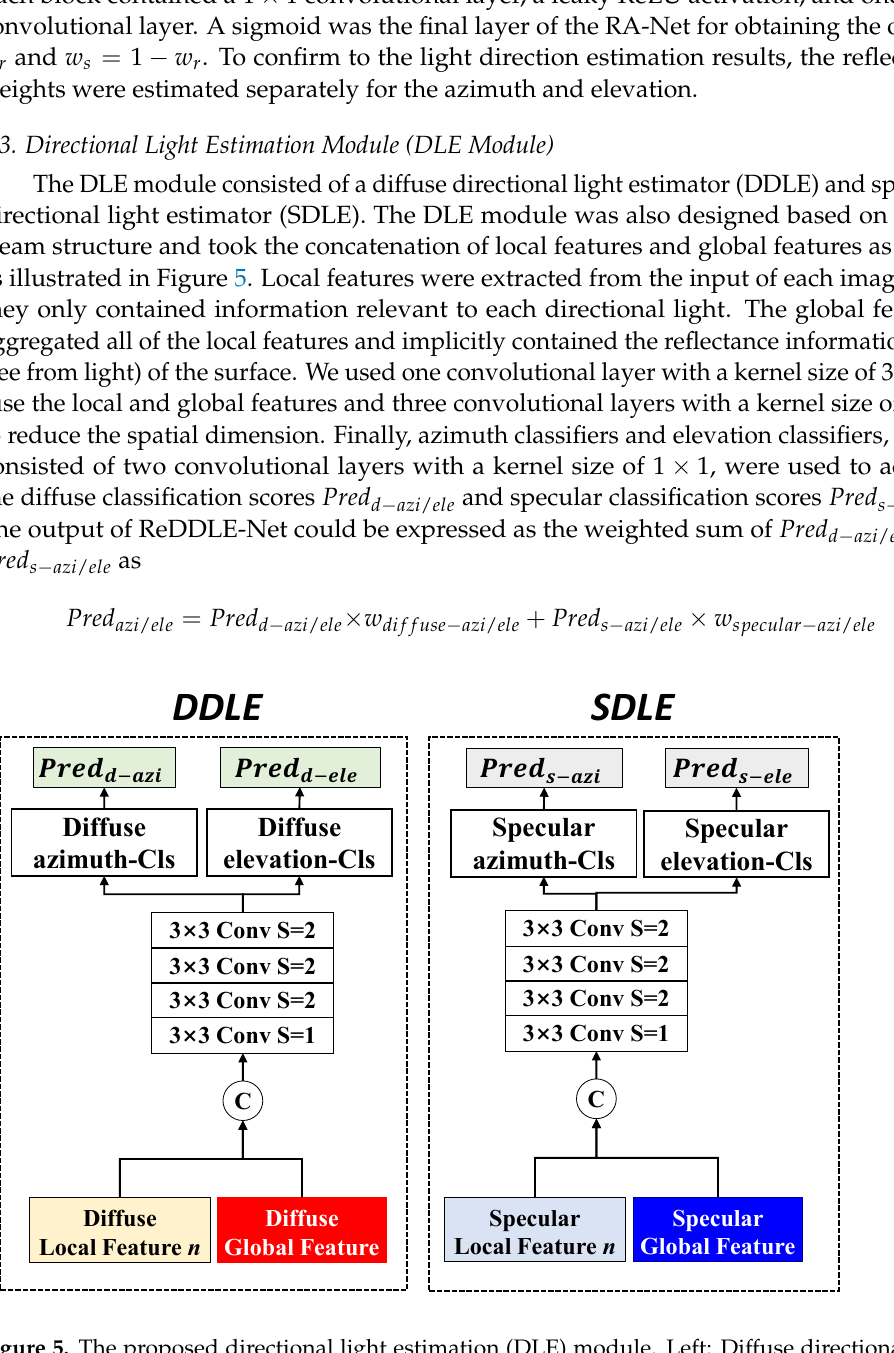
Figure 5. The proposed directional light estimation (DLE) module. Left: Diffuse directional light estimator (DDLE). Right: Specular directional light estimator